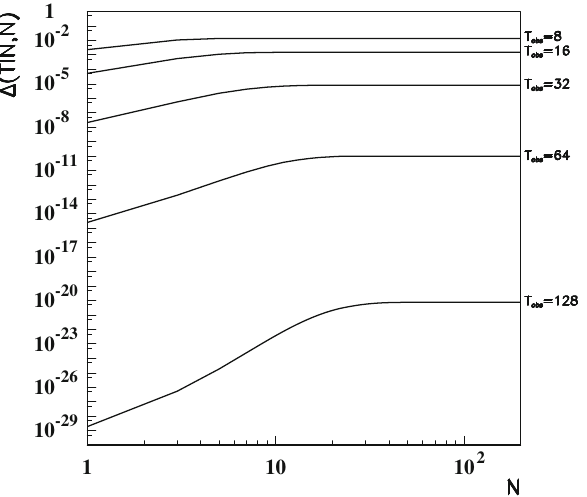
Fig. 4 Δ( T | N , N ) as a function of N for several values of